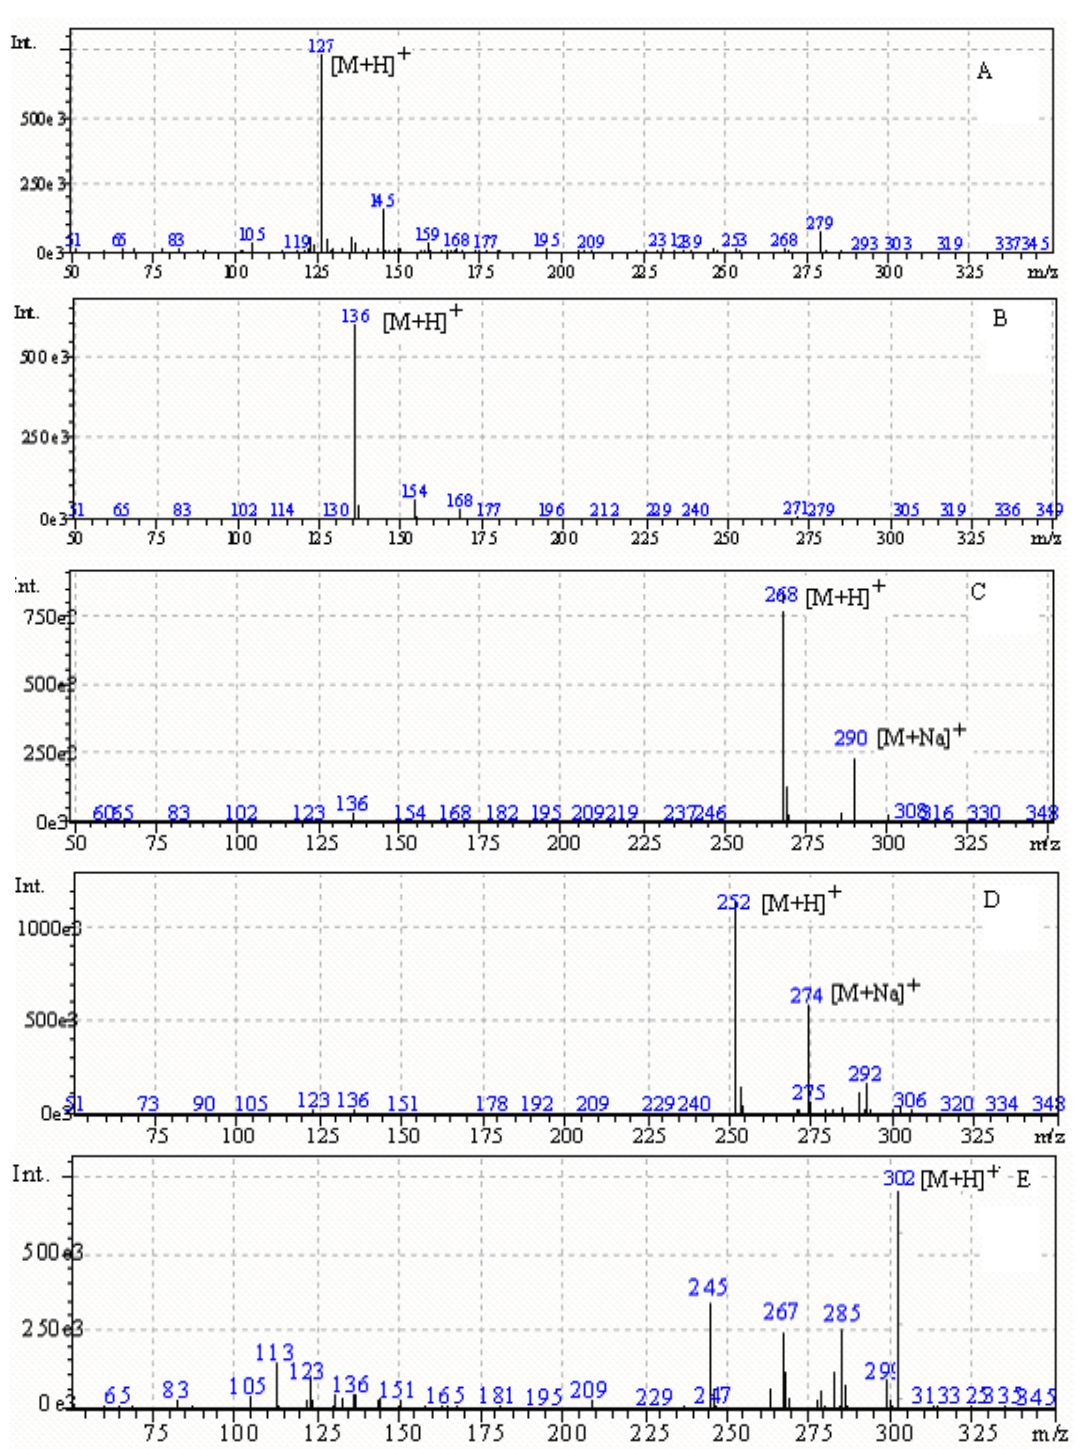
Figure 2. Mass spectra of nucleosides in scan mode: (A) thymine; (B) adenine; (C) adenosine; (D) cordycepin; (E)